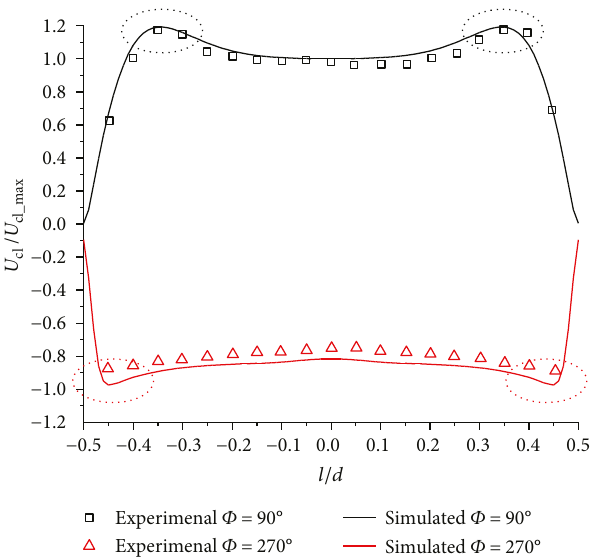
Figure 8: Comparison of normalized velocity of the exit line at di ff erent exit phase angles between the experiment and the